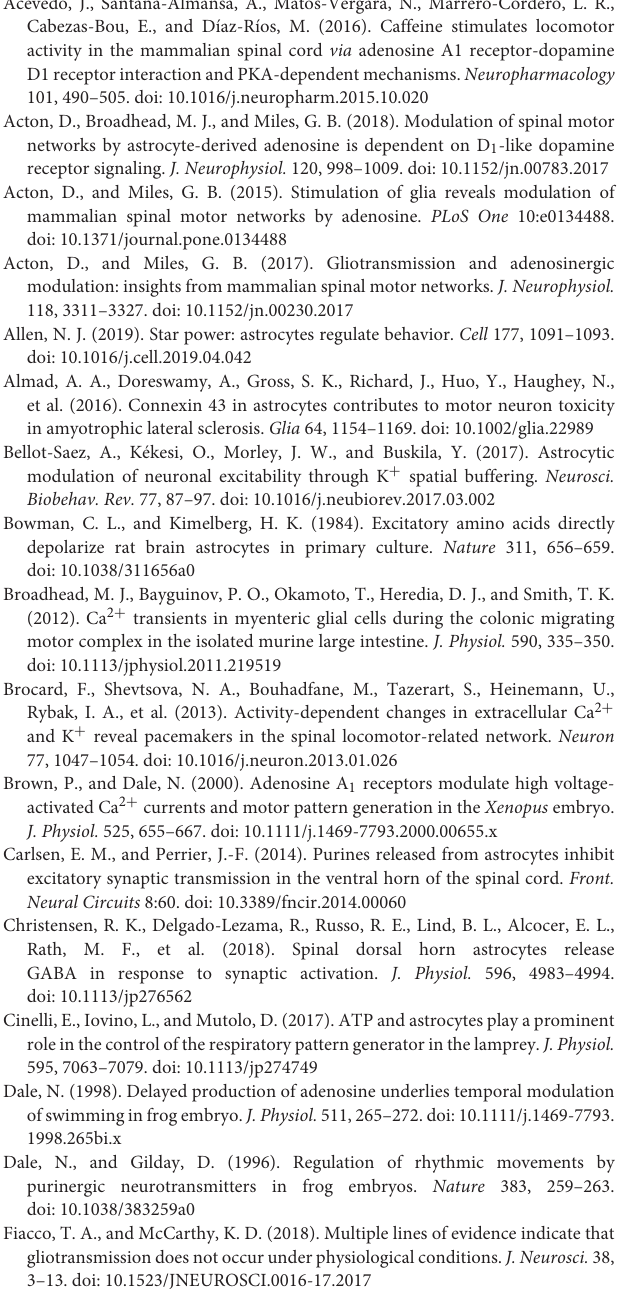
(non-transgenic) spinal cords. (D) Bar charts displaying the burst duration under control, CNO and wash conditions for GFAP::Cre;hM3Dq spinal cords. (E) Bar charts displaying the burst duration under control, CNO and wash conditions for GFAP::Cre;hM4Di spinal cords. (F) Bar charts displaying the burst amplitude under control, CNO and wash conditions for control (non-transgenic) spinal cords. (G) Bar charts displaying the burst amplitude under control, CNO and wash conditions for GFAP::Cre;hM3Dq spinal cords. (H) Bar charts displaying the burst amplitude under control, CNO and wash conditions for GFAP::Cre;hM4Di spinal cords. ns, not